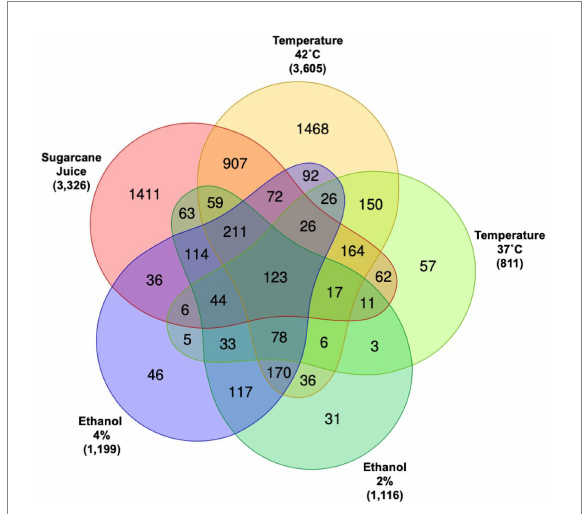
FIGURE 2 Venn diagram of differentially expressed genes (DEGs) for all conditions. The Venn diagram shows how many DEGs are shared between all conditions and how many are exclusive for each condition. Numbers outside of the Venn diagram represent the total of DEGs when compared to each respective control.